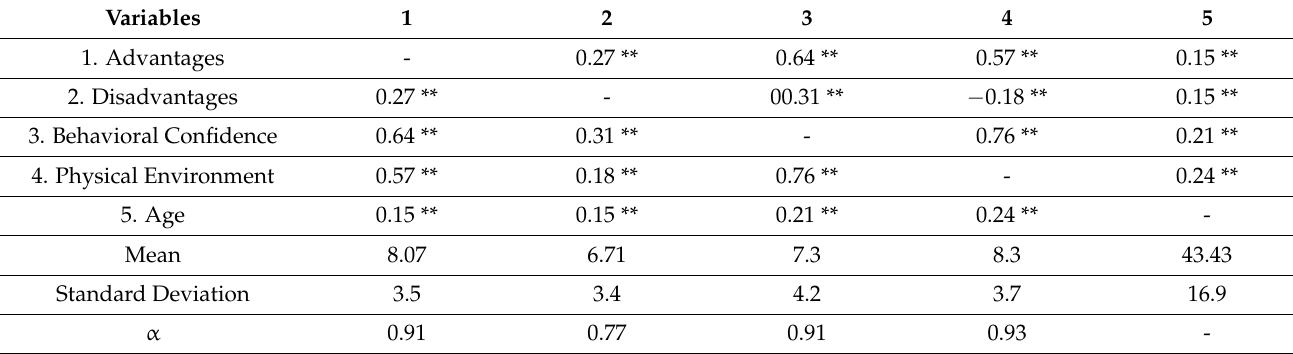
Table 4. Pearson correlations, and reliability estimates for study variables in the sample population ( n = 428).